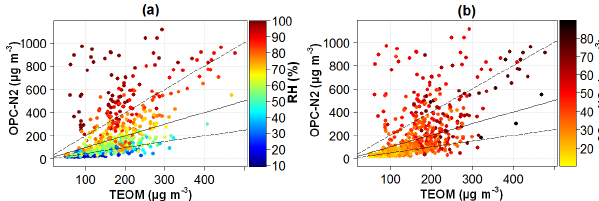
Figure 4. Derived OPC-N2 uncorrected PM 2 . 5 mass concentrations against TEOM PM 2 . 5 mass concentration measurements coloured by (a) ambient RH and (b) the sum of the particle sulfate and ni- trate concentrations in Delhi. The solid line is the 1 : 1 line, and the dashed lines are the 0 . 5 : 1 and 2 : 1 lines.